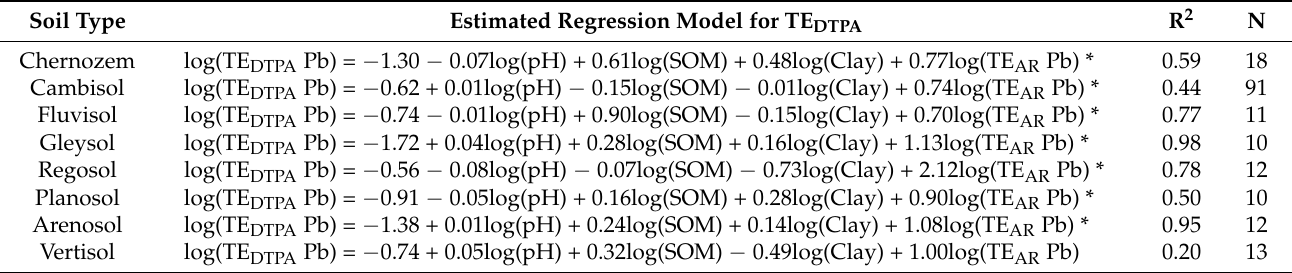
Table 11. Prediction model